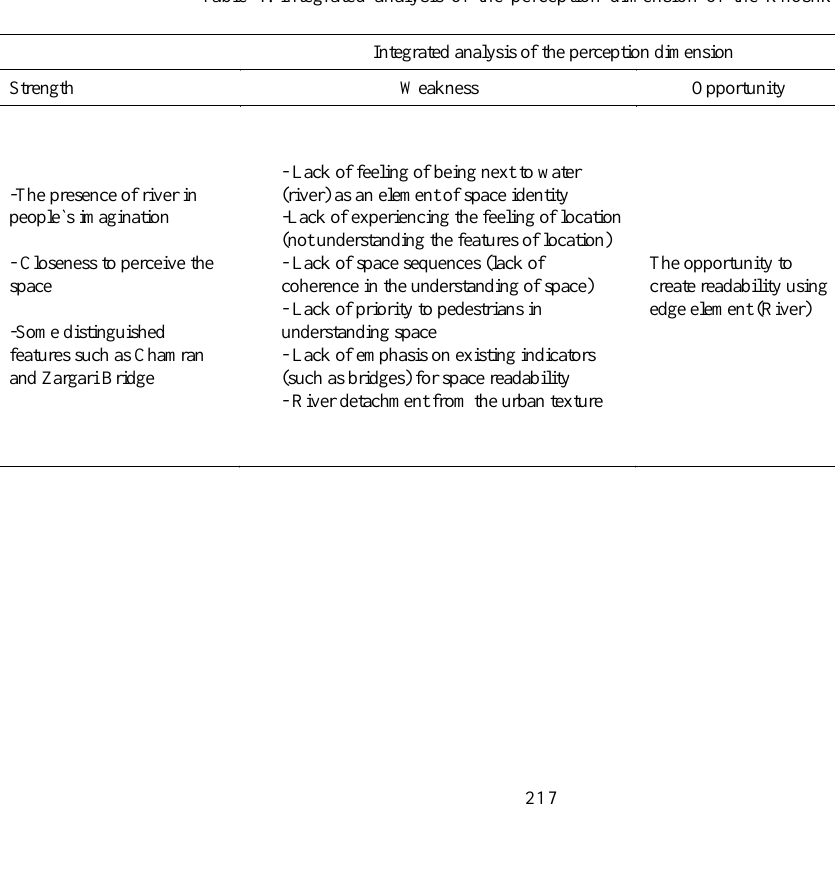
Table 4: Integrated analysis of the perception dimension of the Khoshk